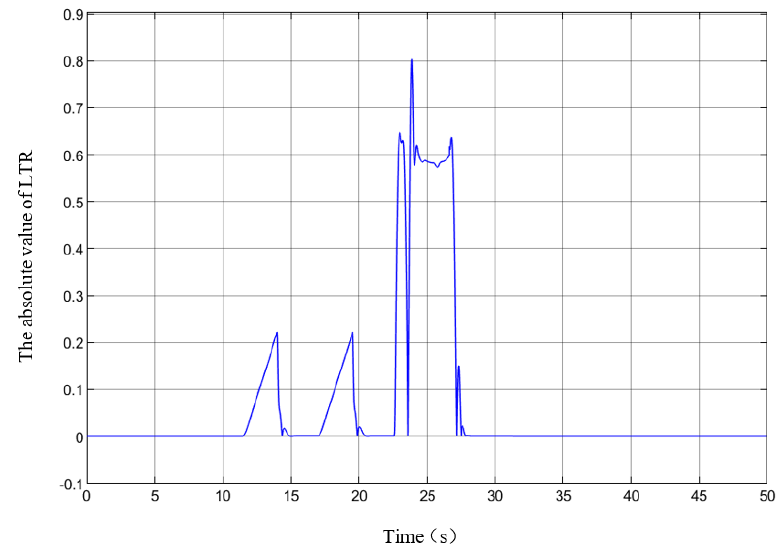
Figure 5. Absolute value change curve of LTR for fishhook test.